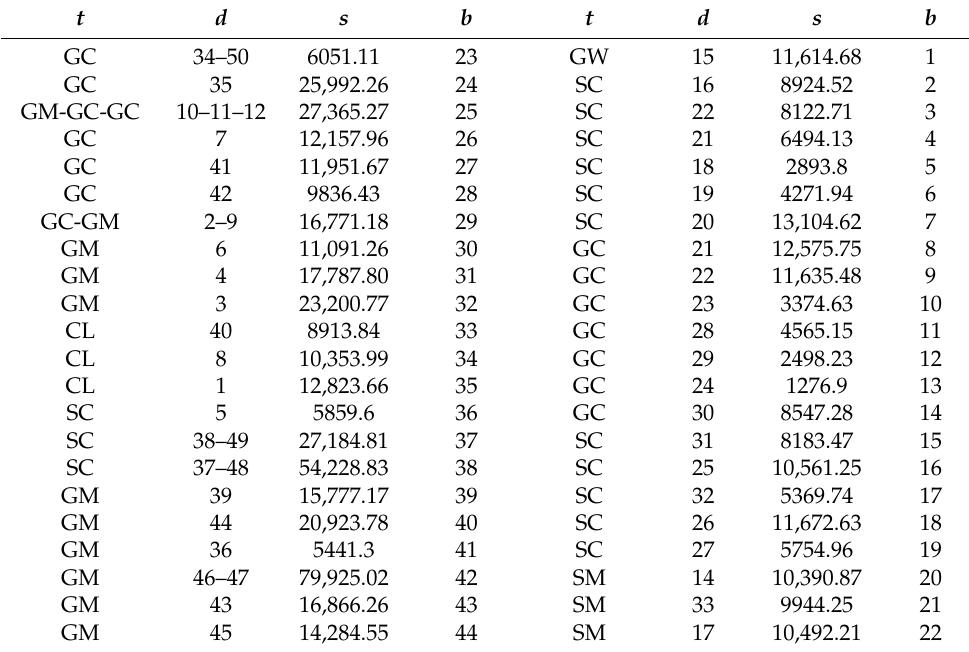
Table 3. Numerical results obtained for the area of each research block ( b ) in terms of square meters ( s ), number of study boreholes ( d ), and soil type in each research borehole ( t